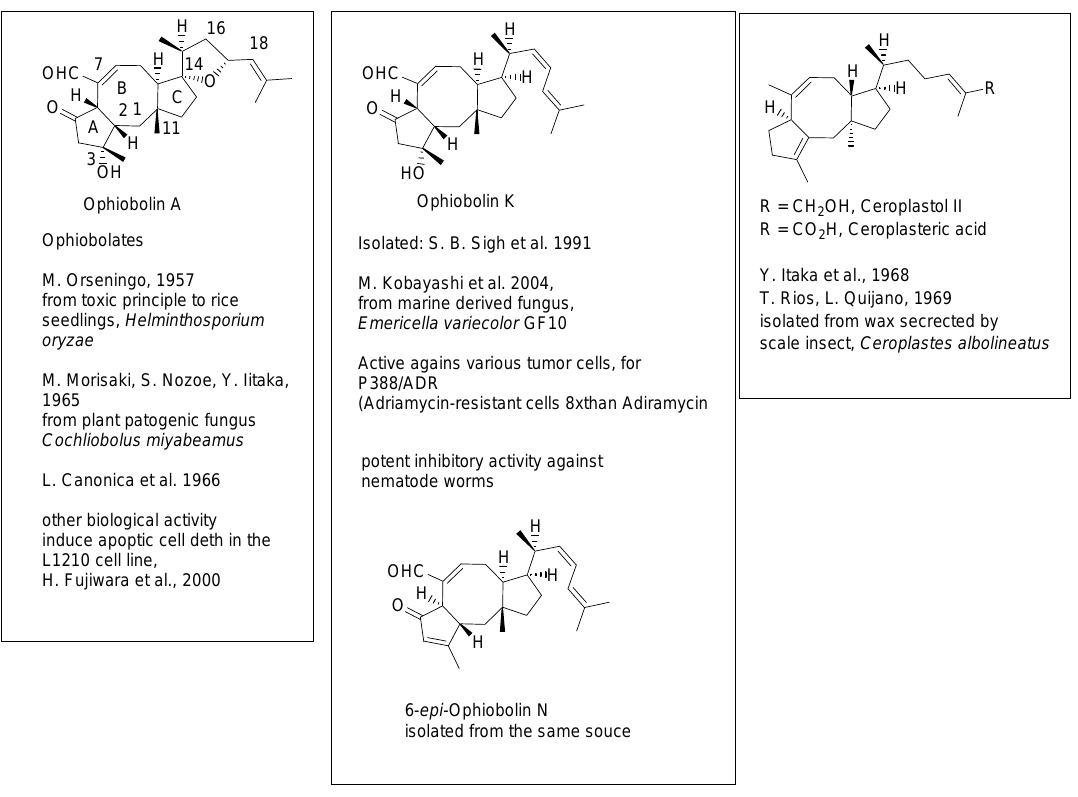
Scheme 1. Ophioboins. Selected